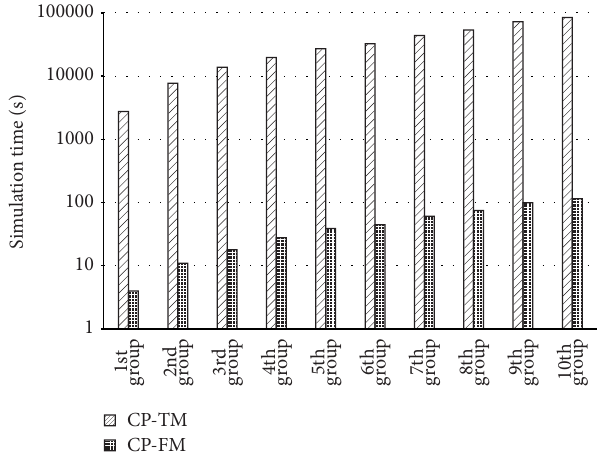
Figure 10: Comparison of simulation speeds of the function- accurate model and timing-accurate model of CPU pipeline.